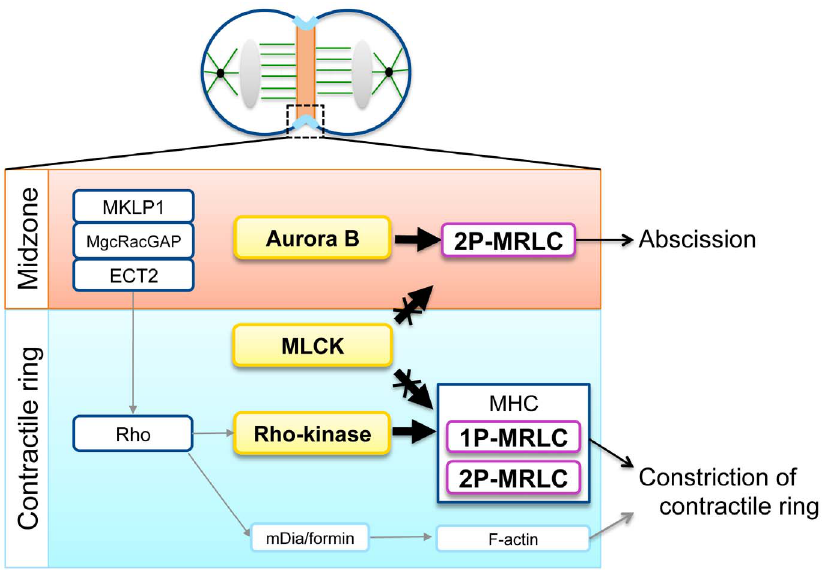
Figure 7. Distinct roles of 1P- and 2P-MRLC during cytokinesis. At the midzone (upper), the localization of 2P-MRLC is controlled by Aurora B and is essential for cell abscission. Moreover, at the contractile ring (lower), Rho signaling proteins, including MKLP1, MgcRacGAP, ECT2, Rho, and Rho kinase, but not MLCK and Aurora B, regulate the localization of 1P-MRLC, 2P-MRLC, and F-actin during cytokinesis, and they are essential for constriction of the contractile ring. The localization of MLCK and Rho kinase was described according to the literature ([40] and [68], respectively). The Rho-dependent regulation of F-actin by mDia/formin was performed as previously described [69]. Table S1 Quantitative analysis of the fluorescence intensity of F-actin, phosphorylated MRLC, MHC, and Rho-signaling proteins in cells depleted of Rho-signaling proteins or Aurora B. Each value represents the relative fluorescence intensity of the indicated proteins in cells treated with MKLP1, MgcRacGAP, ECT2, or Aurora B siRNAs. Numbers in red indicate a significant difference compared with each control (p , 0.05, t -test). (DOC)